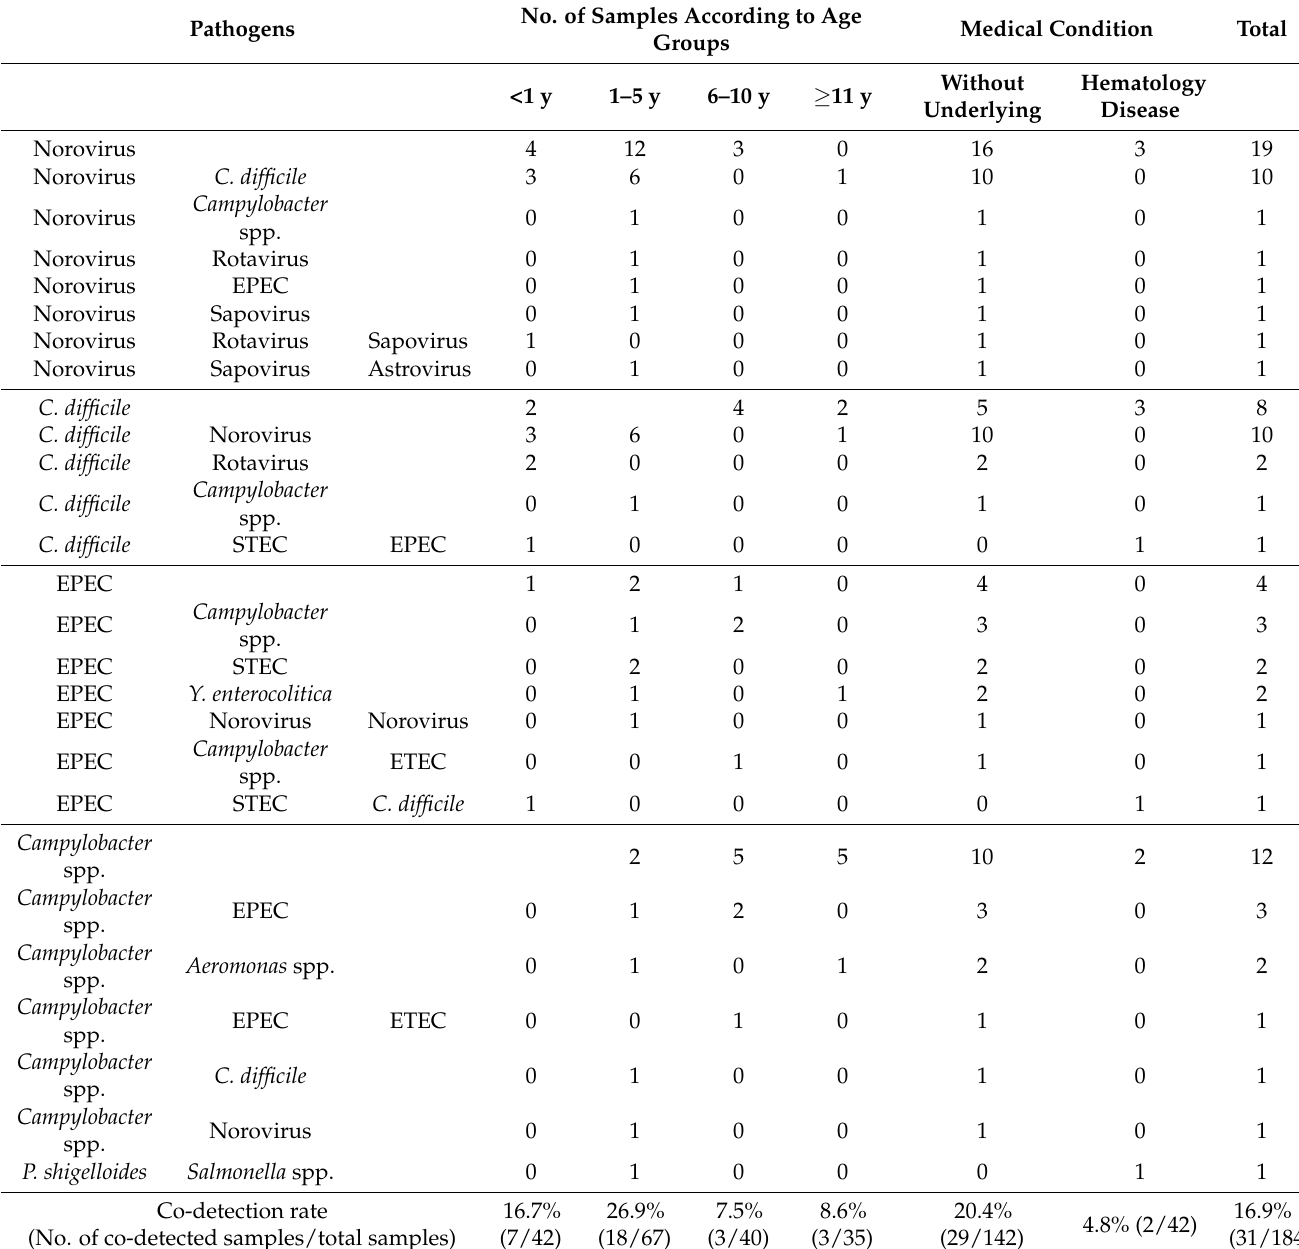
Table 5. Distribution of co-detected pathogens according to age group and medical